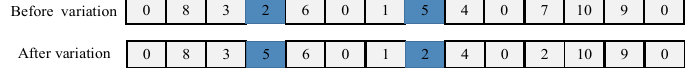
Figure 6. Schematic Diagram of Chromosome Variation Process.